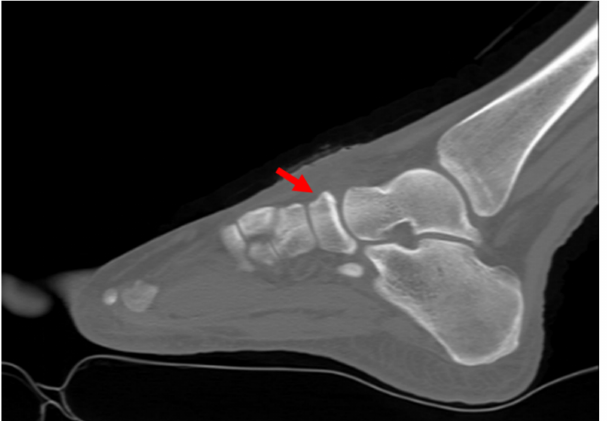
Figure 5. Postoperative sagittal CT image at the 5-month follow-up examination shows that bony union has been achieved